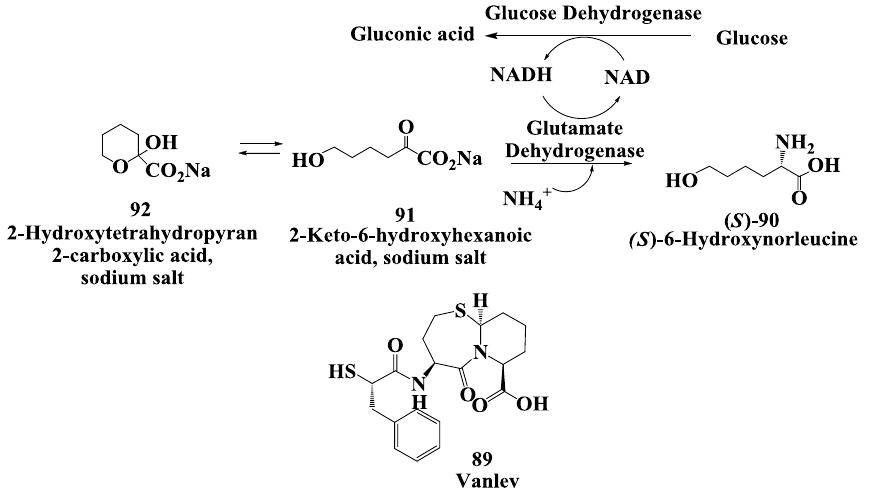
Figure 23. Vanlev: Enzymatic synthesis of ( S )-6-hydroxynorleucine by reductive amination.